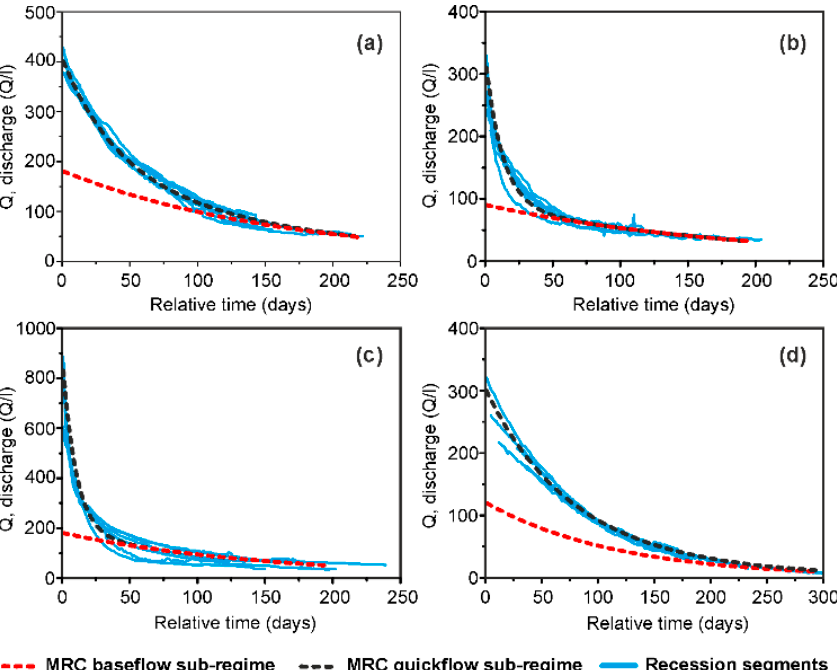
Figure 4. Master Recession Curves of springs with bimodal behavior. ( a ) Scirca spring; ( b ) Vaccara spring; ( c ) Boschetto spring and ( d ) Bagnara spring.